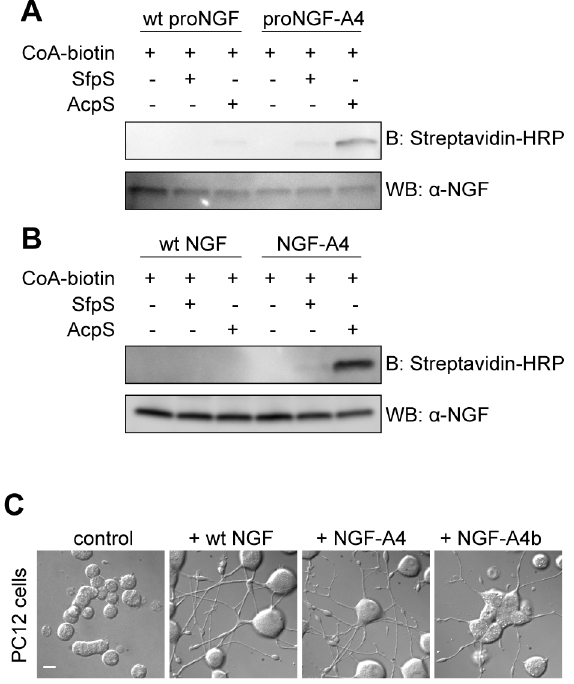
Figure 2. Site-specific biotinylation of proNGF and NGF. A–B ) Western blot for the analysis of the in vitro biotinylation reaction of purified NGF-A4 ( A ) and proNGF-A4 ( B ) using CoA-biotin substrate and AcpS or SfpS PPTases. The same biotinylation reaction is performed in parallel using untagged wt NGF and wt proNGF as negative controls. Streptavidin-HRP is used for detection of biotin. The anti-NGF blot is the loading control. C ) Typical DIC images obtained when performing the differentiation assay in PC12 cells using , 50 ng/ml of wt NGF, NGF-A4 and biotinylated NGF-A4 (NGF-A4b). Untreated cells are the control. Scale bar: 20 m m.